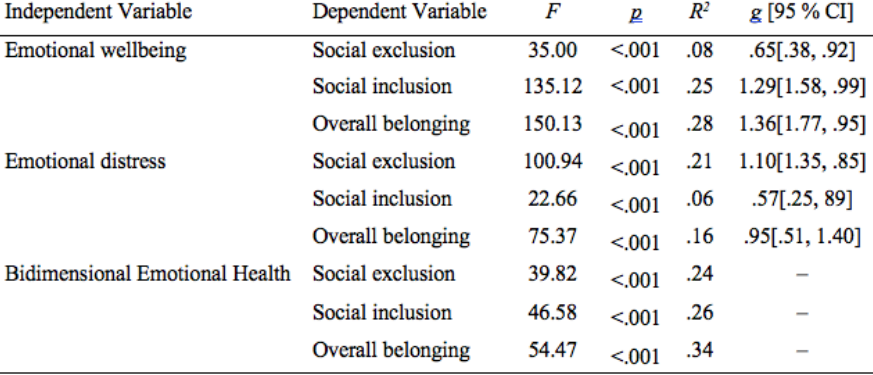
Univariate analysis of variance